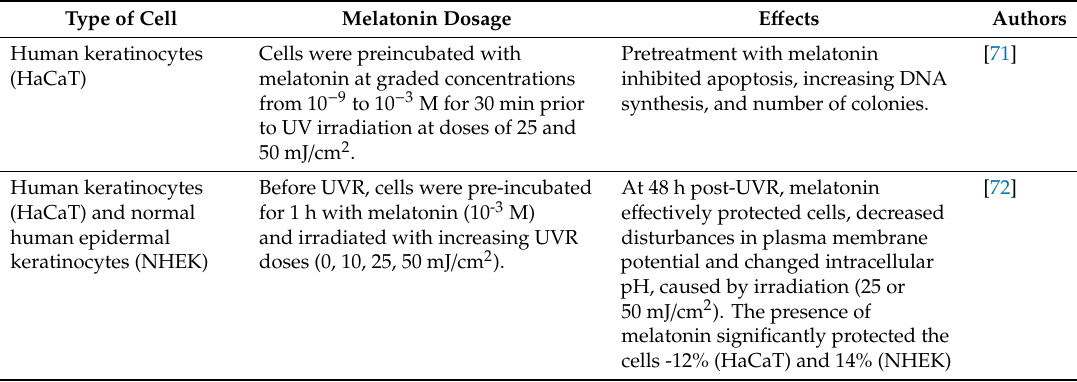
Table 1. Studies of the e ff ects of melatonin on irradiated skin